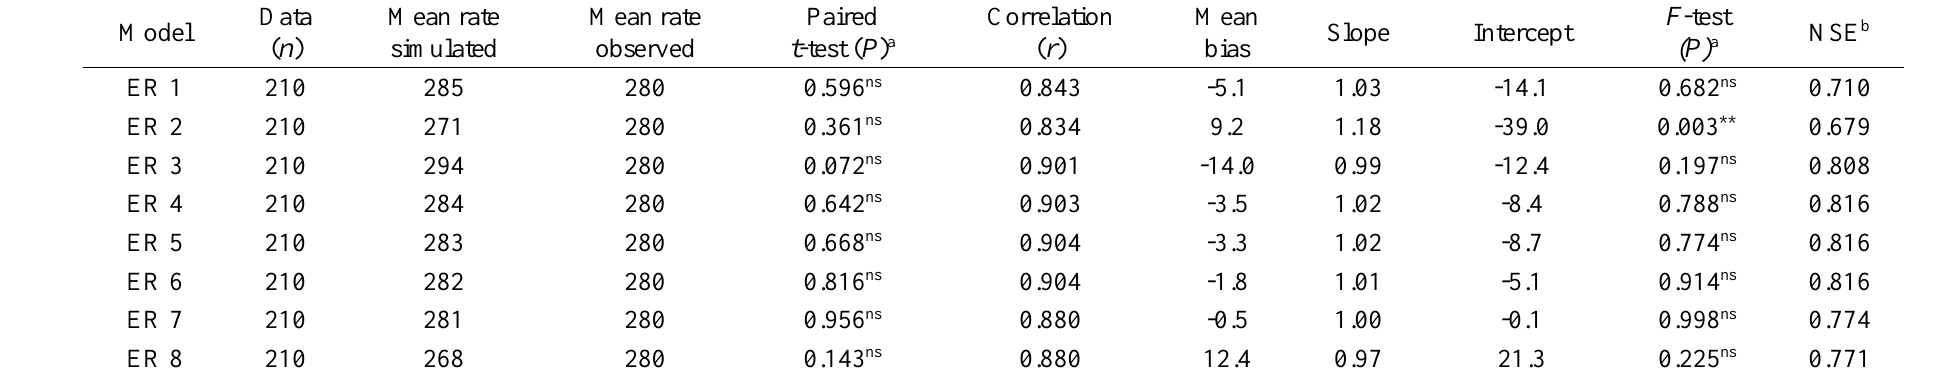
Table A3. Model performance statistics for ecosystem respiration (ER) models fitted to data from control (C) treatments. Model